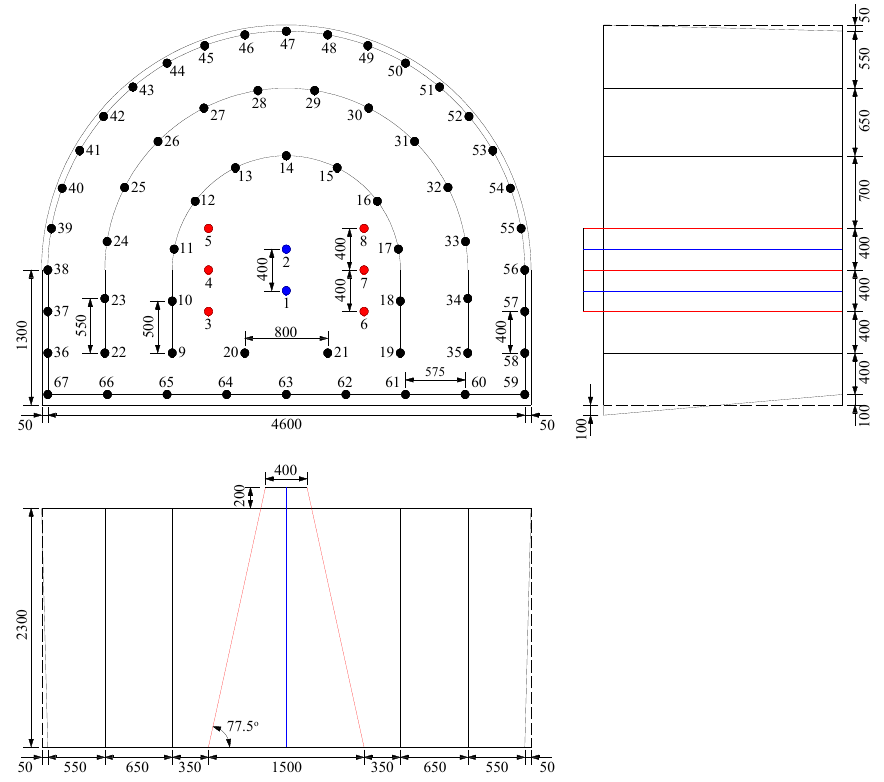
Figure 10. Blasting hole layout of the original scheme (unit: mm).